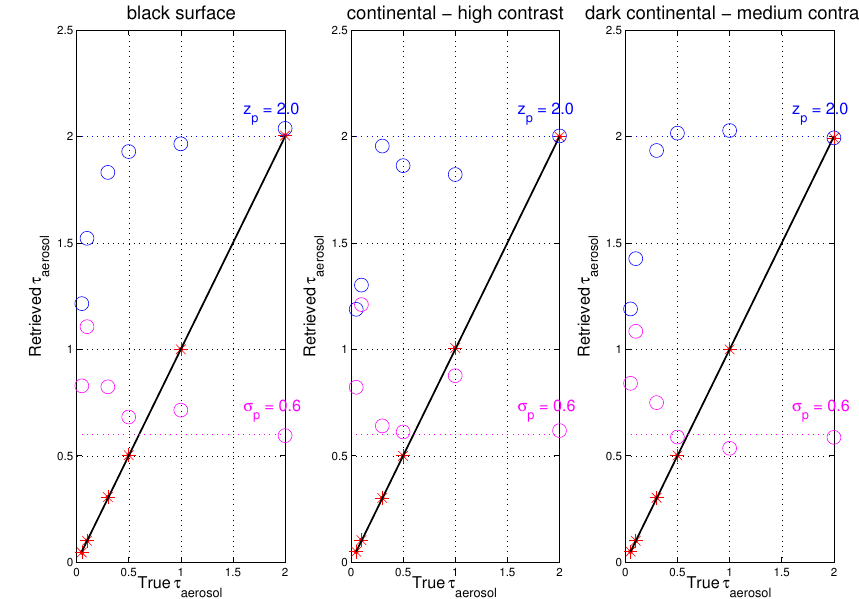
Fig. 5. Synthetic retrievals of aerosol optical thickness τ aerosol (red asterisks), peak height z p (blue circles) and peak width σ p (magenta circles), for varying τ aerosol and fixed parameters z p =2km (blue dashed line) and σ p =0.6 (magenta dashed line). The black line is the 1:1 line. A coarse urban absorbing aerosol (IA3) has been used. The viewing geometry is statistically representative for SCIAMACHY observations over Kanpur with SZA=43 ◦ , LZA=11 ◦ , Azimuth=149 ◦ . Left panel: black surface, ρ A = ρ B =0, middle panel: land surface having high contrast, ρ A =0.22, ρ B =0.03, right panel: dark land surface having medium contrast, ρ A =0.13, ρ B =0.09.